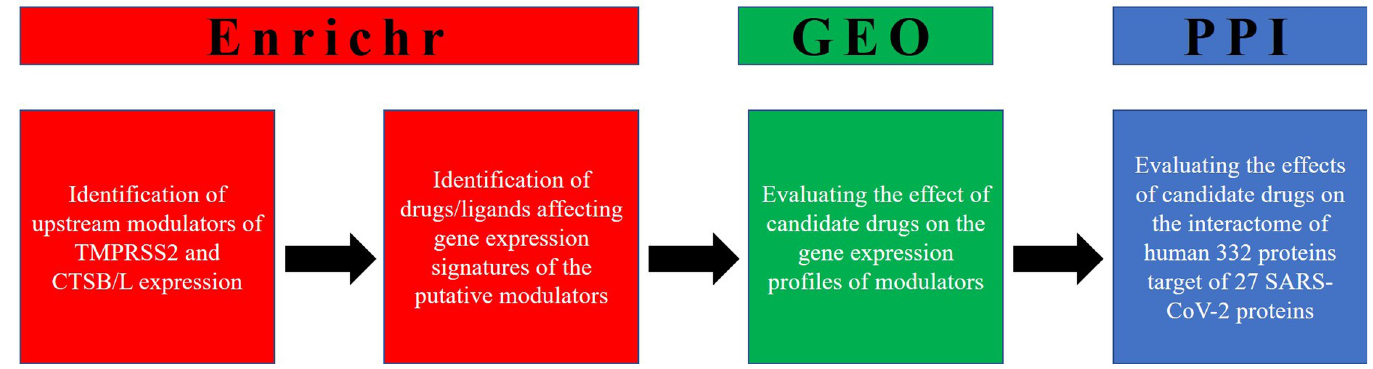
Fig 1. A strategic workflow describing the identification of candidate drugs targeting the regulators TMPRSS2 and CTSB/L identified through GSEA.